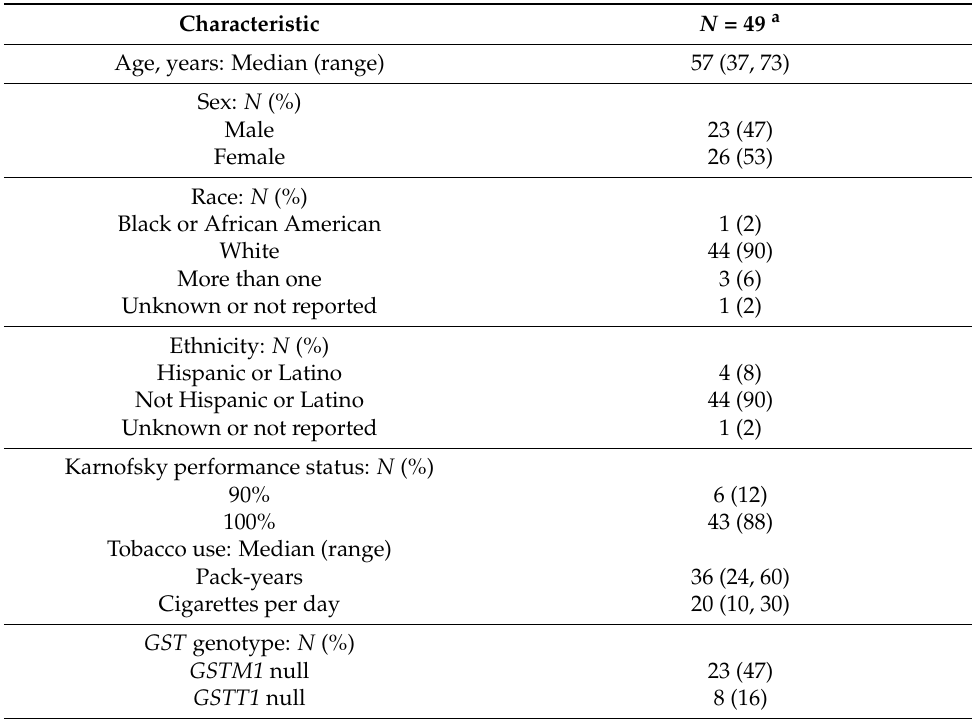
Table 1. Baseline characteristics.